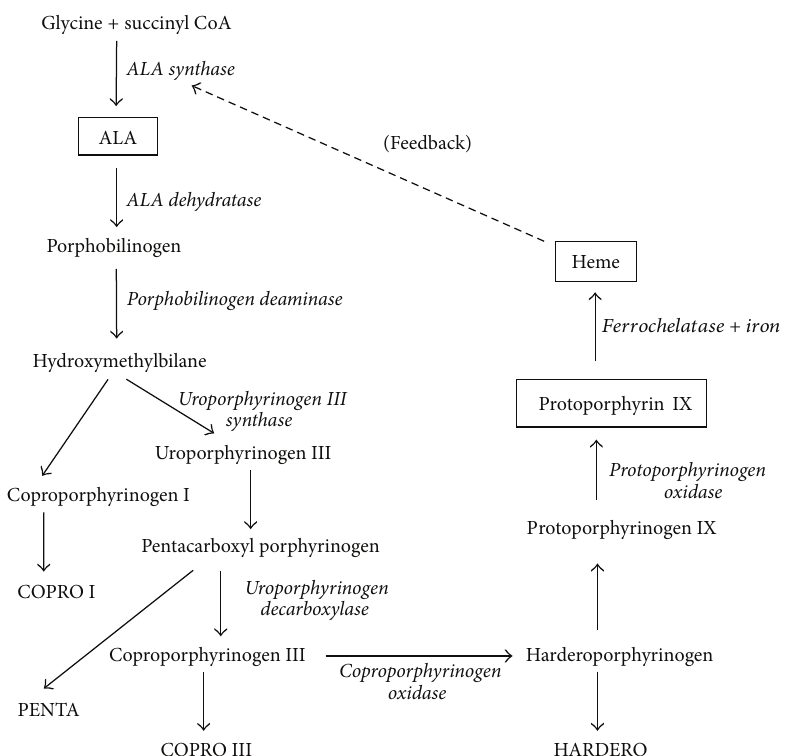
Figure 1: The simplified synthetic pathway of ALA-induced PpIX. ALA is an endogenous substance. It is incorporated into the mitochondria, repeatedly transported between the cytoplasm and the mitochondria, and finally used for heme synthesis. ALA is converted into porphobilinogen by the enzyme ALA dehydratase, and porphobilinogen is sequentially converted into hydroxymethylbilane, uroporphyrinogen III, coproporphyrinogen III, protoporphyrinogen IX, and finally PpIX by the enzyme protoporphyrinogen oxidase. The final product heme is synthesized from PpIX and iron (Fe) by the enzyme ferrochelatase (FeC). This biosynthetic pathway is considered to be the same in all organisms (PENTA: pentacarboxyl porphyrin, COPRO I or III: coproporphyrin I or III, and HARDERO: